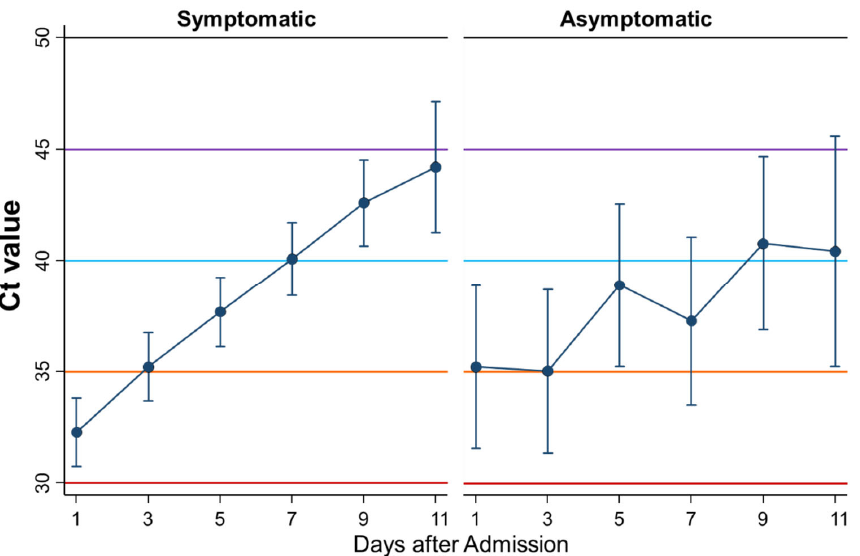
Figure 3. Differential kinetics of Ct values between symptomatic and asymptomatic patients. Mean Ct with 95% confidence intervals. When the Ct value is 40 or more, the PCR test result is considered